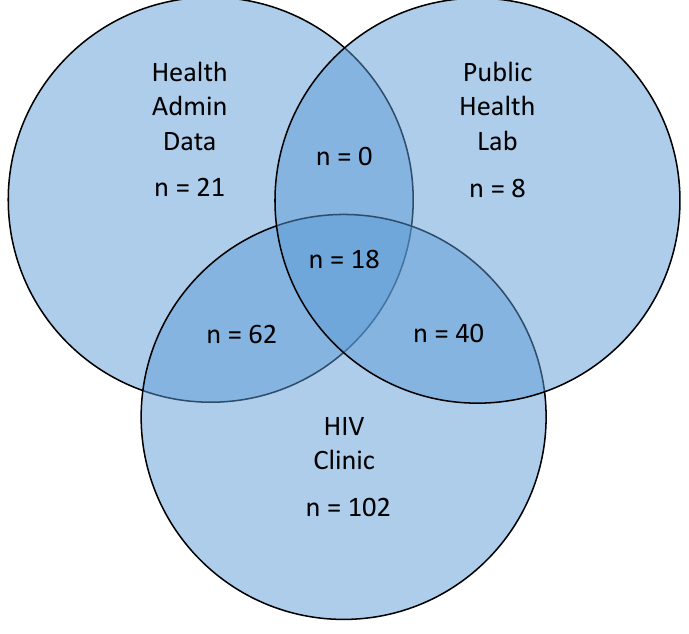
Figure 2: Diagram of the data sources of PLHIV in NL who were still alive at the end of the study